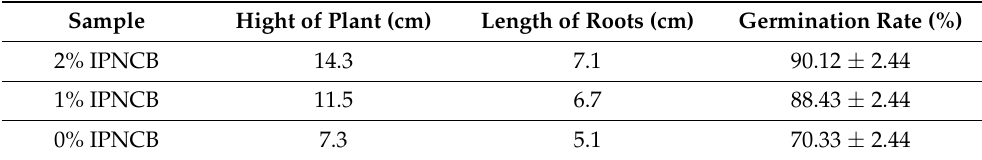
Table 7. Effect of IPNCB Composite on Wheat Plant